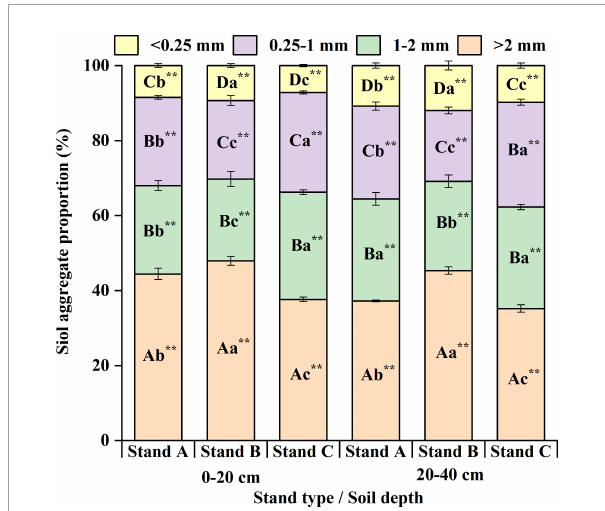
FIGURE2 Soil aggregate distribution in Chinese fir plantations with different stand types. Data indicate the average of 5 replicates ± standard deviations. Various capital letters stand for significant differences among the different aggregate sizes at P < 0.05. Various lowercase letters stand for significant differences among the different stand types at P < 0.05. ** and * stand for significant differences among the different soil depths at P < 0.01 and P < 0.05, respectively. ns Stands for no significant differences among the different soil depths.